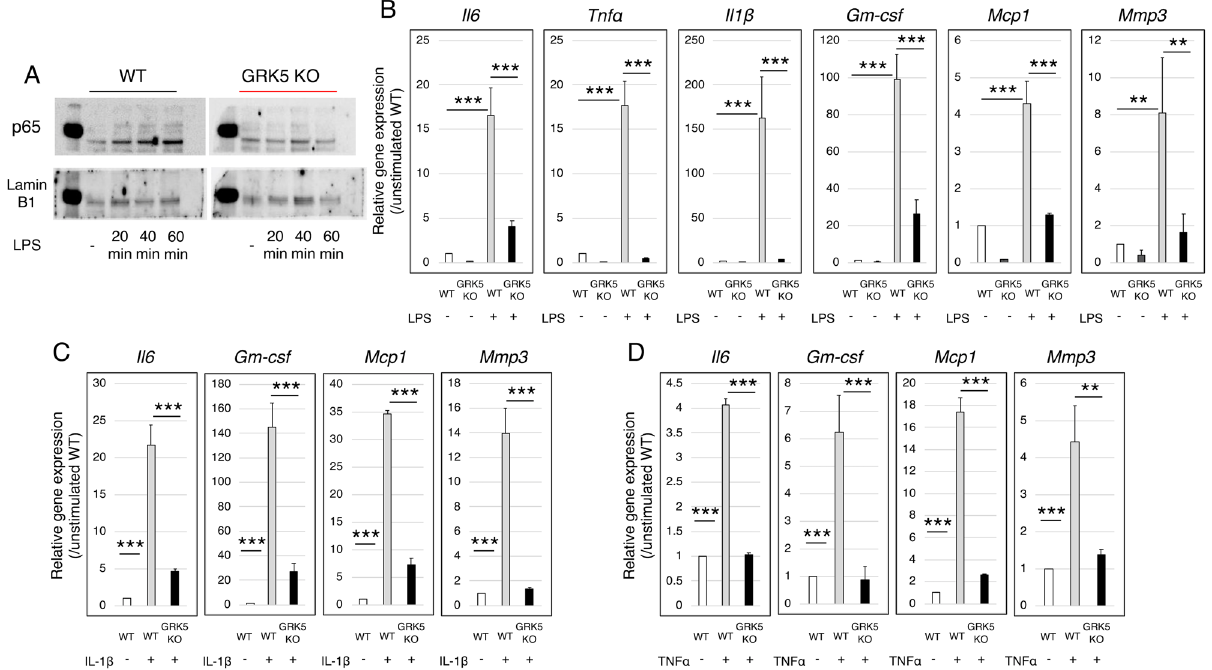
Figure 6. Effects of GRK5 knockout on p65 nuclear translocation and on the expression of inflammatory genes after inflammatory stimulation in murine FLSs. ( A ) Representative p65 nuclear translocation at 20, 40 and 60 min after LPS stimulation in GRK5 knockout (KO) and WT murine FLSs. ( B , C , D ) Changes in gene expressions in response to ( B ) LPS, ( C ) IL-1β, or ( D ) TNFα stimulation in GRK5 KO and WT murine FLSs. Values are means ± SD (n = 3). ** P < 0.01; *** P <